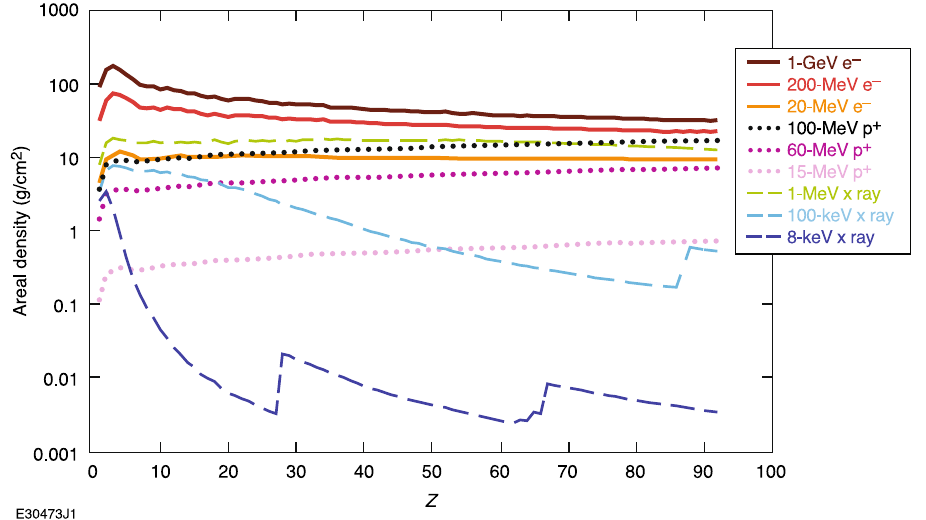
Figure 1. Areal density needed for a factor of 1/ e reduction in particle flux versus atomic number ( Z ) for average, mid-scale, and high-probe-energy laser-driven electron, X-ray, and proton probes. Charged-particle ranges are determined via continuous slowing-down approximation, while X-ray ranges were determined with mass attenuation coefficients 20,21